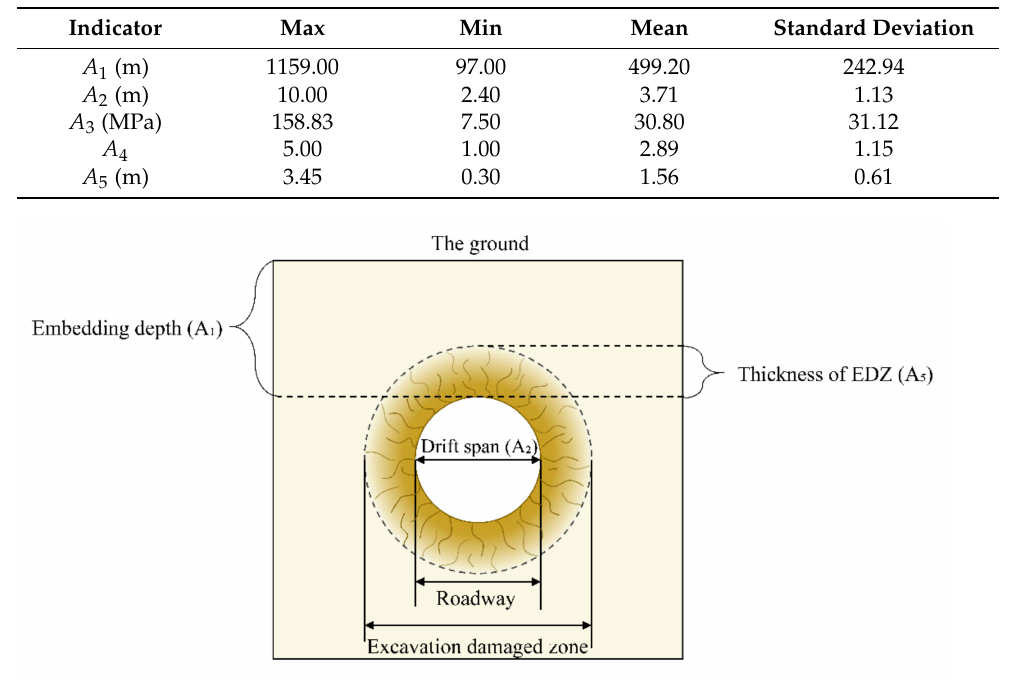
Table 1. Statistics for each indicator.